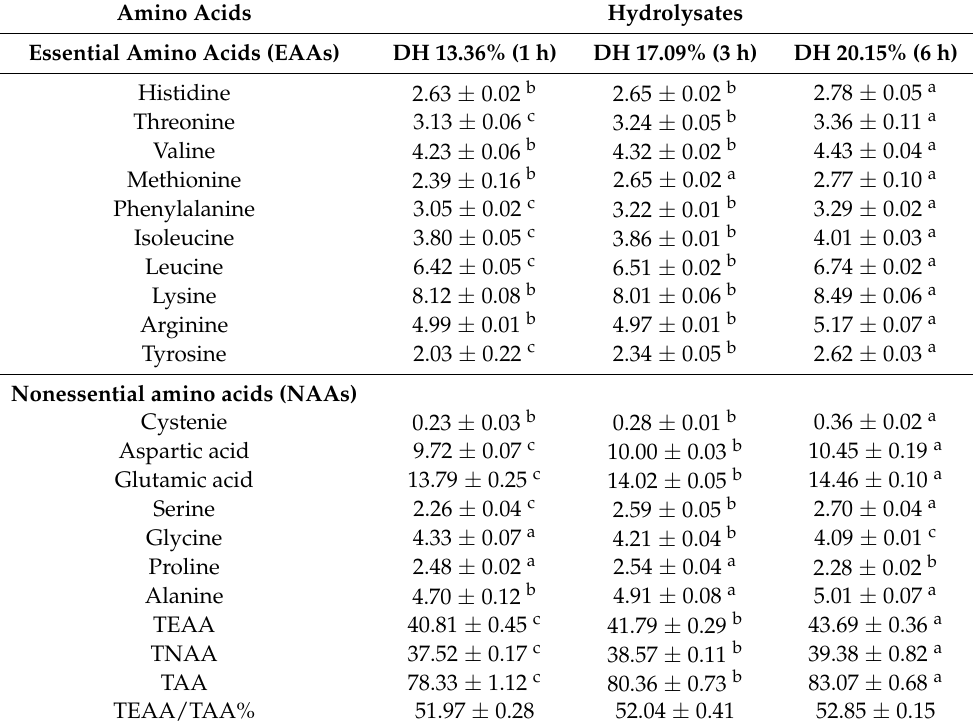
Table 3. Amino acid content of bighead carp protein hydrolysates (g/100 g protein) derived using ficin enzyme under optimal